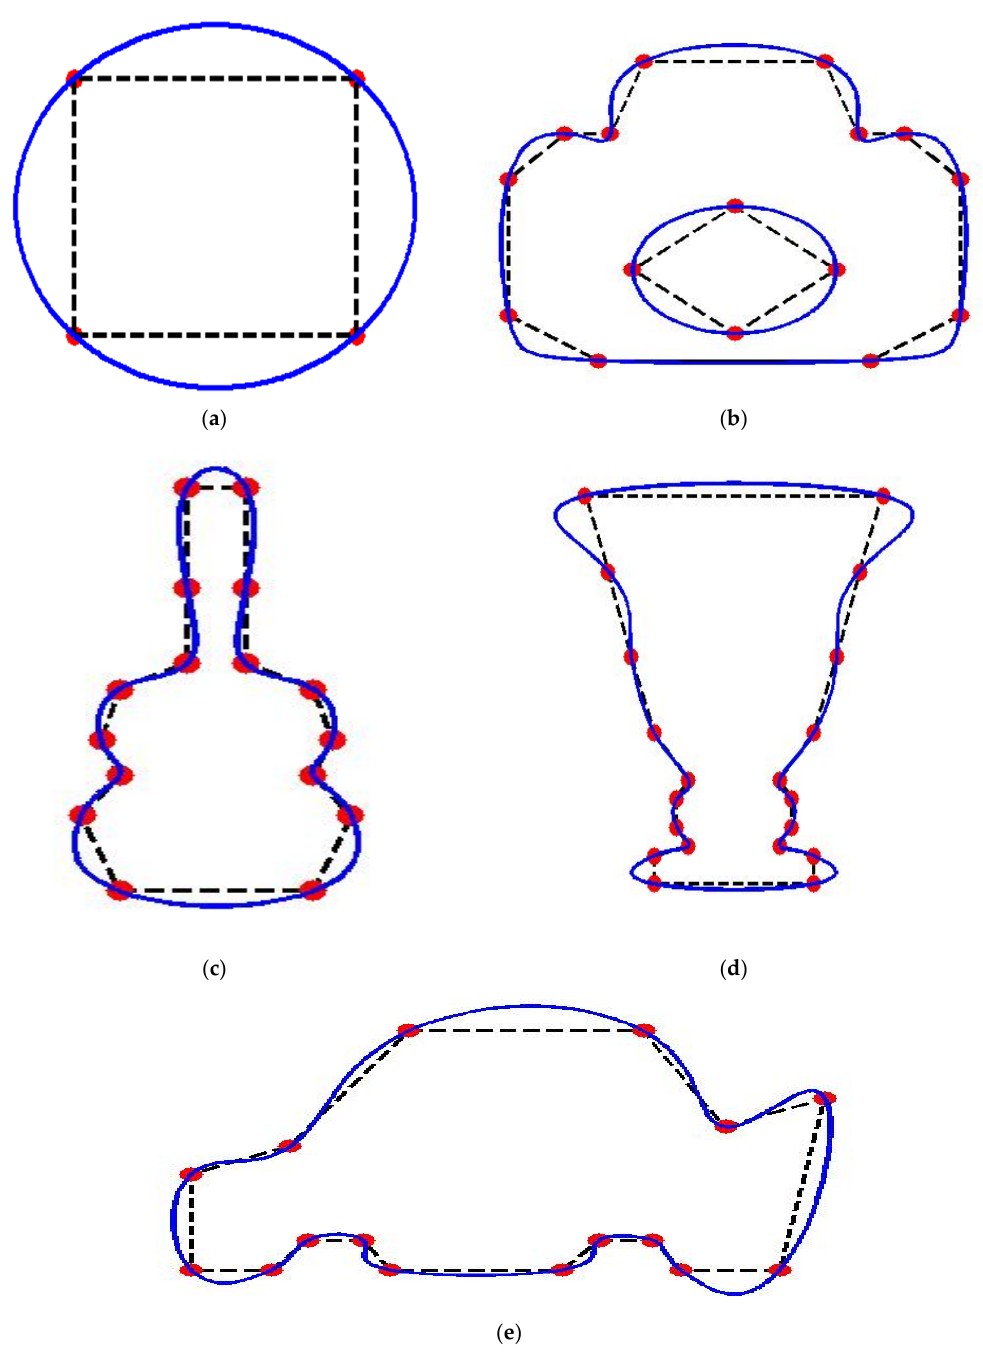
Figure 7. The different objects ( a – e ) are interpolated by default RQTS with periodic end condition.